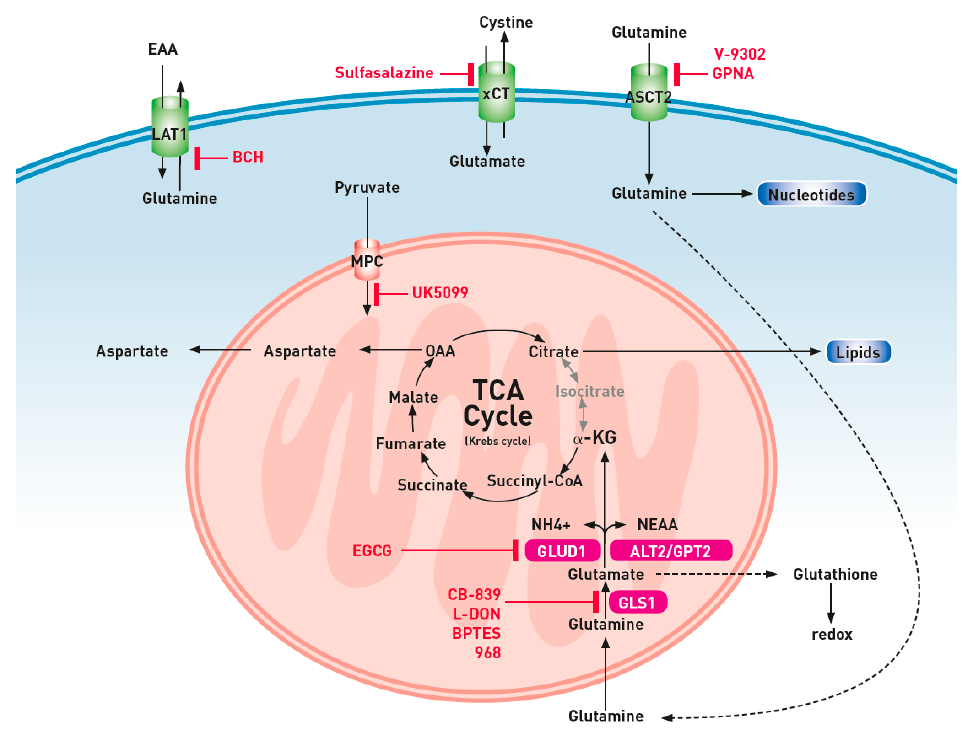
Figure 2. Targeting glutamine metabolism. ALT, alanine aminotransferase; ASCT2, alanine-serine-cysteine-transporter-2; AST, aspartate aminotransferase; BCH, 2-aminobicyclo-(2,2,1)-heptane-2- carboxylic acid; BPTES, Bis-2-(5-phenylacetamido-1,3,4-thiadiazol-2-yl)ethyl sulfide; EAA, essential amino acids; EGCG, epigallocatechin-3-gallate; GLS, glutaminase; GLUD, glutamate dehydrogenase; GPNA, ʟ -glutamyl-p-nitroanilide; α -KG, α -ketoglutarate; LAT1, ʟ -type amino acid transporter; L- DON, 6-diazo-5-oxo- ʟ -norleucine; MPC, mitochondrial pyruvate carrier; OAA, oxaloacetate; SLC7A11, solute carrier family member 7A11 (xCT).